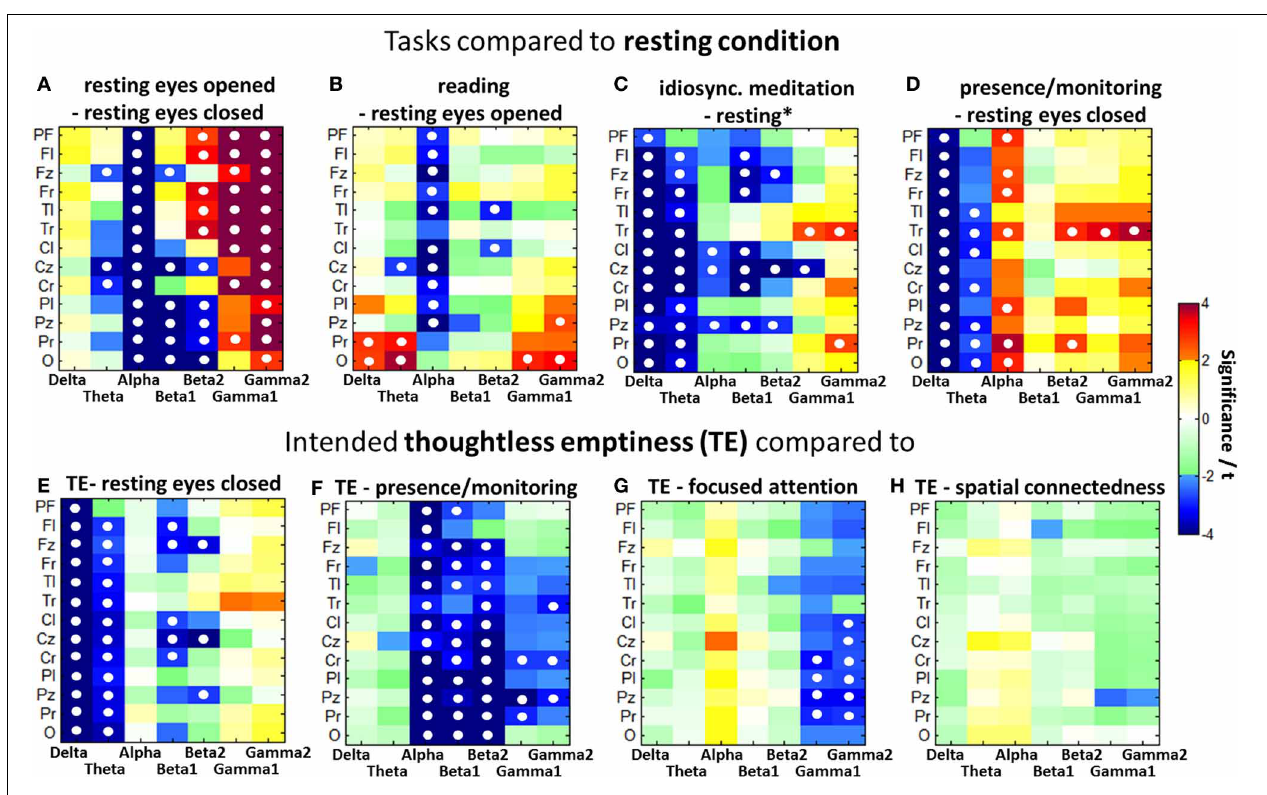
FIGURE 4 | Color-coded PSD differences shown as t -values resulting from eight selected task comparisons (A–H). (A) t -test of 30 experienced participants was calculated from the effect sizes (Cohen’s d) from each